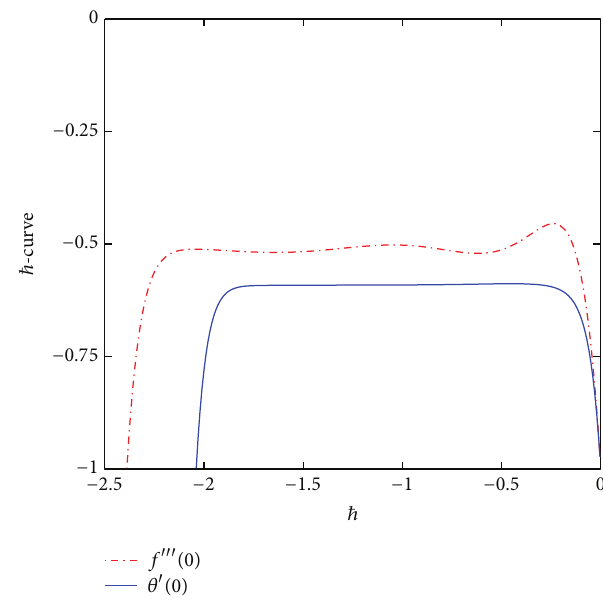
Figure 2: The ℎ -curves of 𝑓󸀠󸀠(0) and 𝜃 󸀠 (0) obtained by the 20th order approximation of the HAM solution when 𝑘 1 = 1.0 , 𝜆 𝑇 = 0.2 , Pr = 1.0 , and 𝑚 = 0.5 .